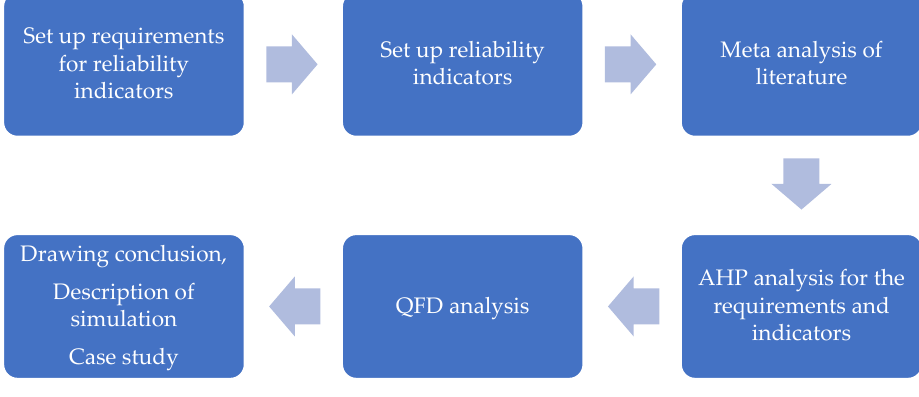
Figure 2. Steps of the research.